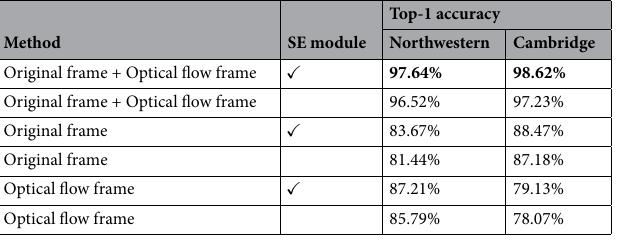
Table 11. Accuracy comparison of ablation experiments. Significant values are in